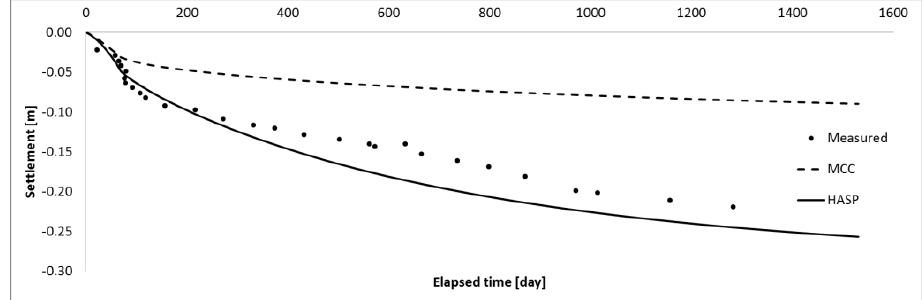
Figure 15. Comparison of settlement-time curves for Embankment B — Point B.